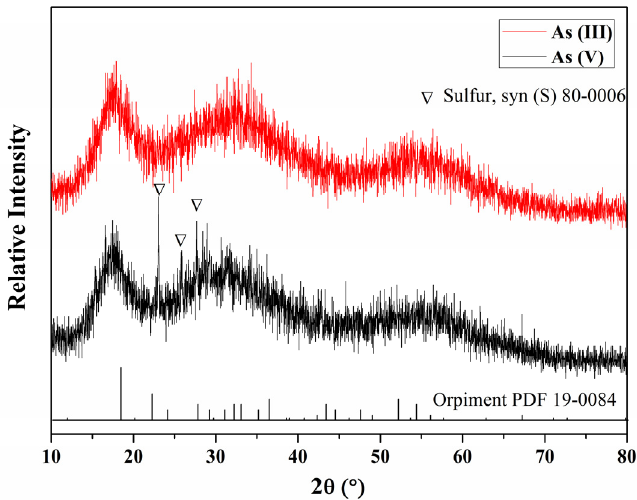
Figure 5. The XRD patterns of the precipitate-As(III) and the